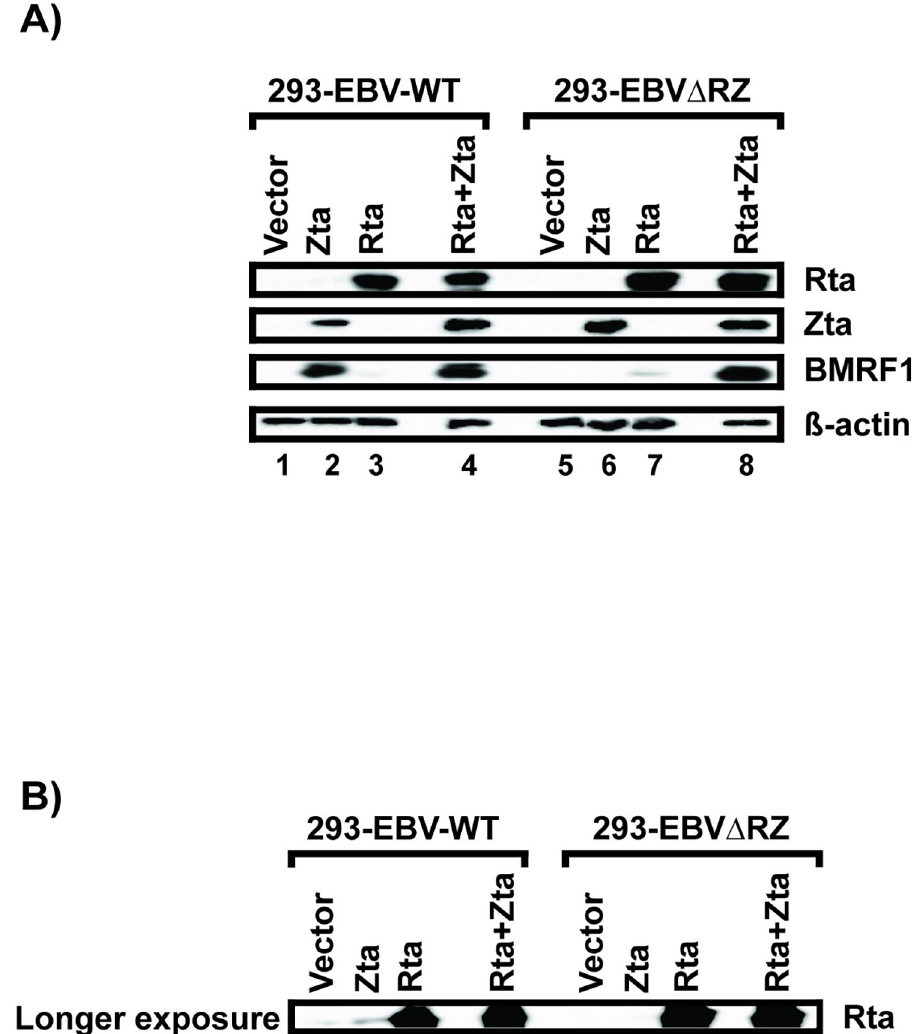
Fig 1. EBV deleted for IE locus allows independent assessment of the role of Rta and Zta in lytic gene regulation. (A) Western blots probed for the indicated EBV, or cell proteins of lysates prepared from 293 cells infected with WT Akata (239-EBV-WT) or Akata Δ RZ virus (293-EBV Δ RZ) transfected with empty vector, or expression plasmid for Zta, Rta, or expression plasmids for both Rta and Zta (Rta+Zta). Data are representative of two independent experiments. Lanes between 3 & 4 and 7 & 8 are deliberately empty. (B) Longer exposure of the Rta western blot shown in (A) reveals that transfected Zta had induced Rta expression in 293-EBV-WT (but not 293-EBV Δ RZ) cells that was not apparent on the shorter